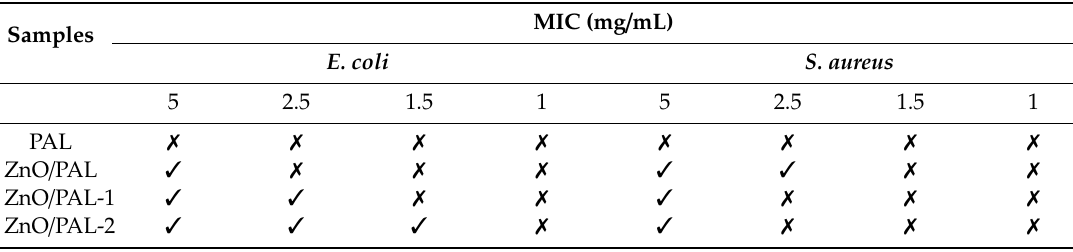
Table 2. The minimum inhibitory concentration (MIC) values of PAL, ZnO / PAL, ZnO / PAL-1 and ZnO / PAL-2 against E. coli and S. aureus